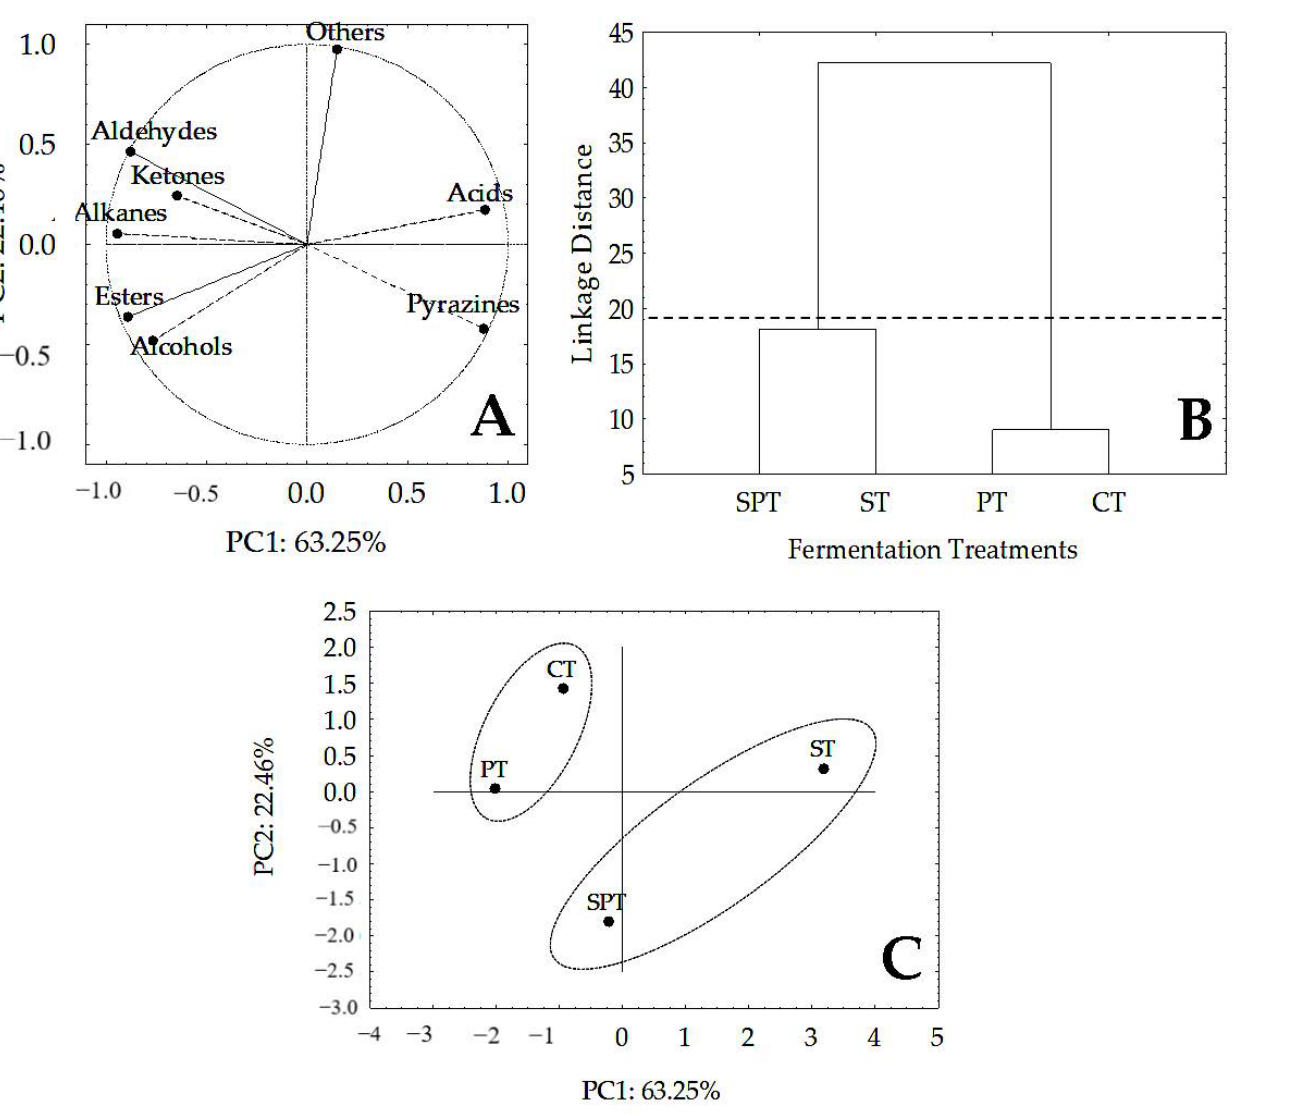
Figure 2. Principal Component Analysis (PCA) and Hierarchical Cluster Analysis (HCA) of volatile compounds in dried and fermented cocoa beans with different starters 1 . Notes: 1 : CT—control treatment, ST— Saccharomyces cerevisiae inoculum, PT— Pichia kudriavzevii inoculum; and SPT— S. cerevisiae and P. kudriavzevii inoculum (1:1). Principal Component Analysis (PCA) ( A , C ). Hierarchical Cluster Analysis (HCA) ( B